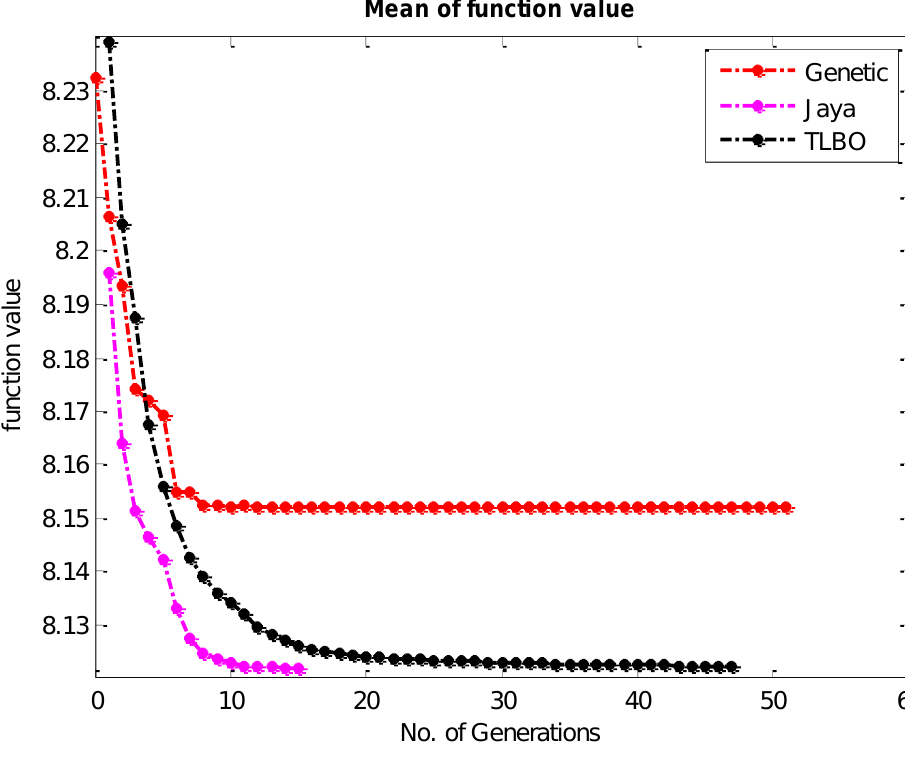
Figure 6. Comparative Convergence plot for the surface roughness by TLBO JAYA and Genetic Algorithm.